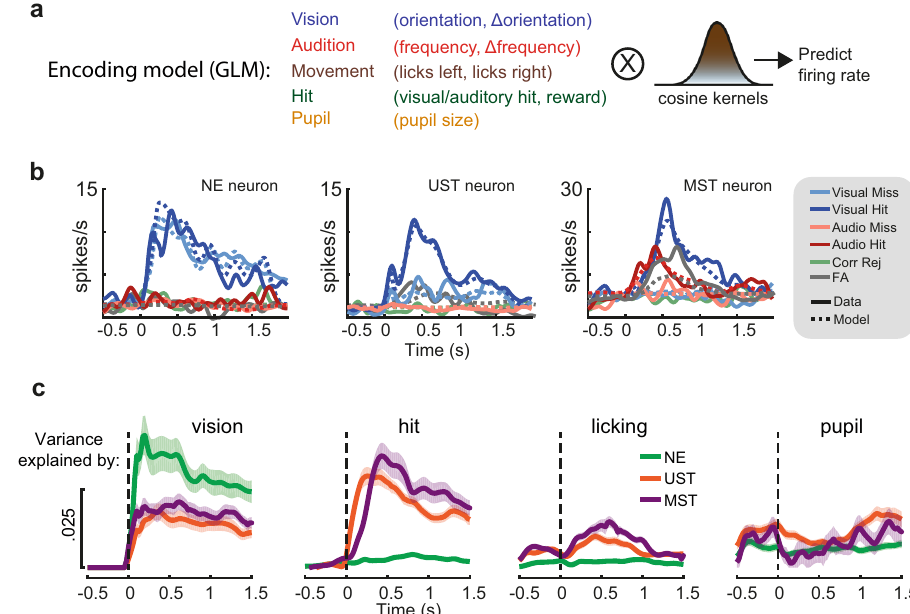
Fig. 3 A generalized linear model dissociates time-varying encoding during late activity. a We constructed a kernel-based GLM encoding model in which variables related to the sensory environment, task, and behavioral state were included as predictors of fi ring rate. Binary task variables were convolved with raised cosine basis functions that spanned the relevant time window to model transient fi ring rate dynamics. b Model fi ts for three example neurons (one V1 neuron from each task version) show that predicted and actual fi ring rates closely overlap and that both sensory-driven activity (example #1), as well as report-related activity for both visual and auditory hits (examples #2 – 3), are captured by the model. The fi ve stimulus-response combinations that had the most counts are plotted (trials with false alarms and licks to the incorrect spout are omitted). c Explained variance over time for subsets of predictors. Each line shows how much fi ring rate variance is explained for each time bin across trials based on only including a subset of all predictors. Shaded area corresponds to